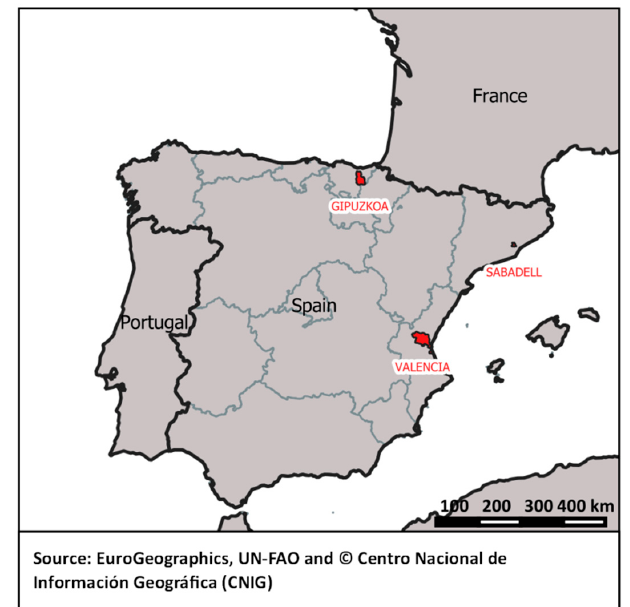
Figure 1. Location map representing the three study areas in Spain.